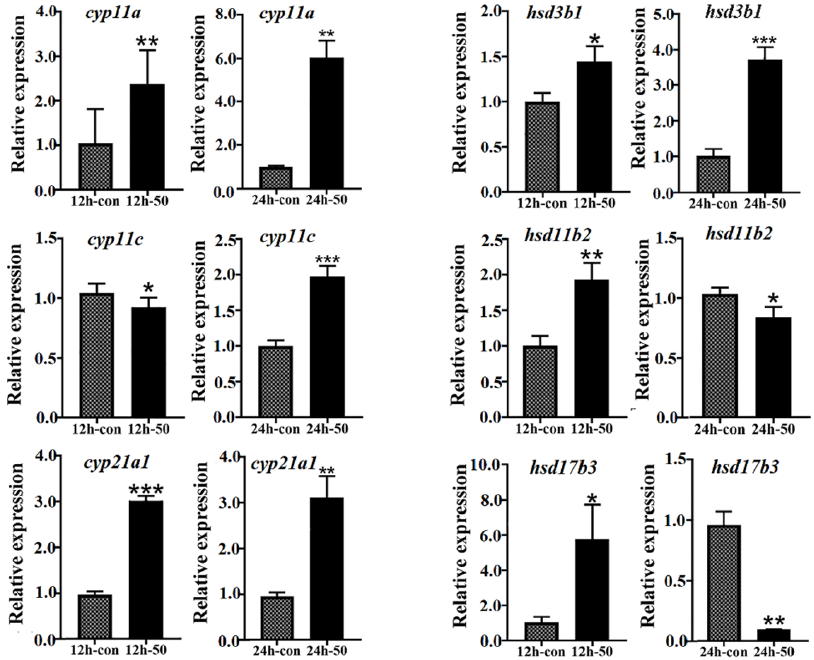
Figure 9. Expression of steroidogenic genes in response to cortisol in vitro stimuli in testes of L. maculatus . * represents p < 0.05; ** represents p < 0.01; *** represents p < 0.001.